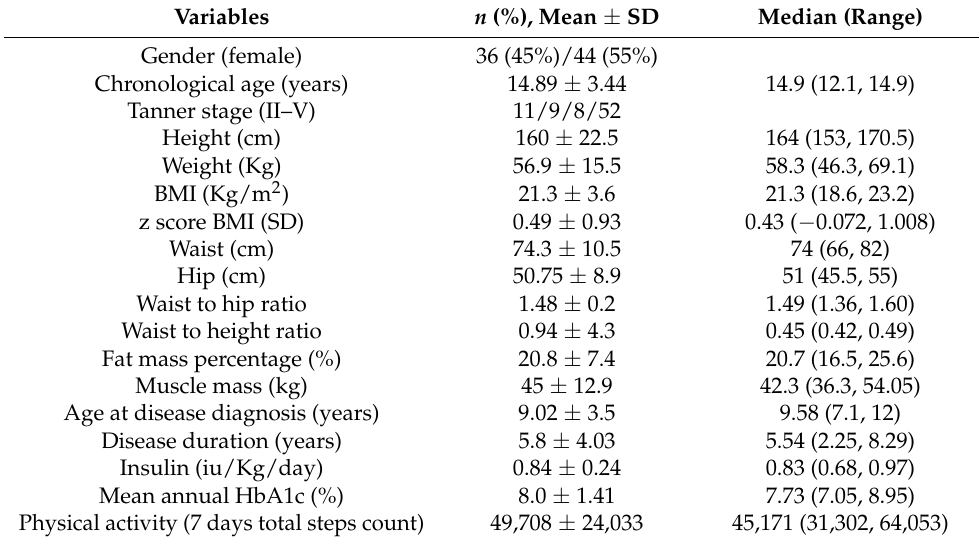
Table 1. Basic demographic and clinical parameters of study population.